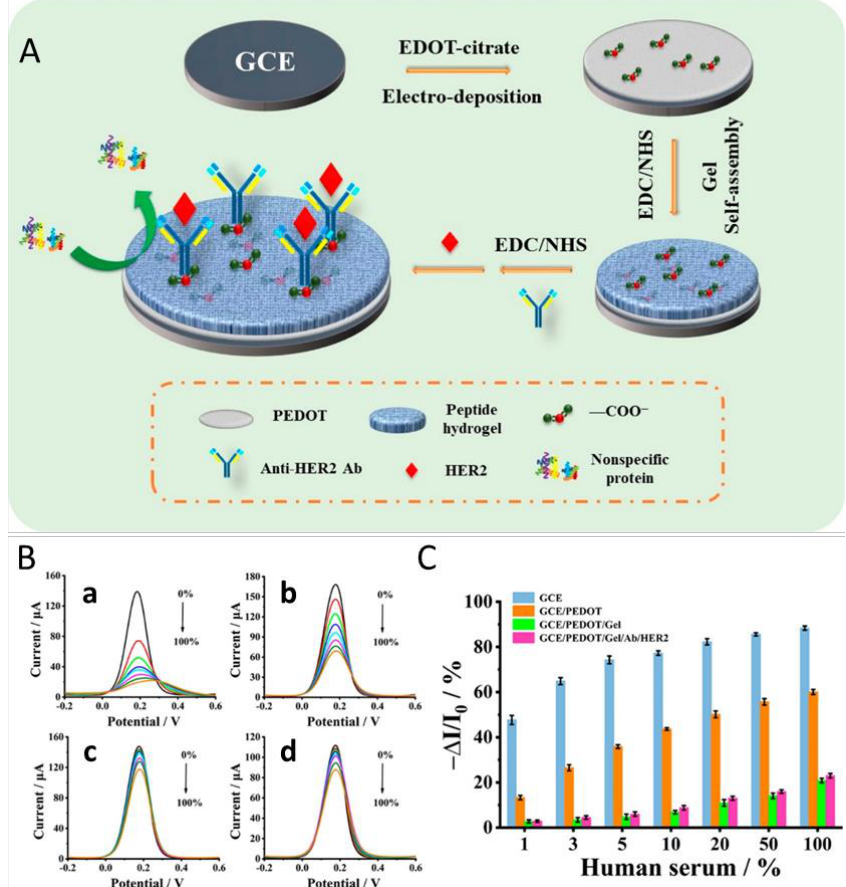
Figure 1. ( A ) Schematic representation of the PEDOT/peptide hydrogel sensor preparation. ( B ) DPV responses of ( a ) bare GCE, ( b ) GCE/PEDOT, ( c ) GCE/PEDOT/gel. and ( d ) GCE/PEDOT/Gel/Ab/HER2 after incubation in human sera with different concentrations. ( C ) The corresponding signal change rates of different electrodes. Error bars show the standard deviations of three repeated measurements. (Reprinted and adapted with permission from [25]. Copyright 2022 American Chemical Society).